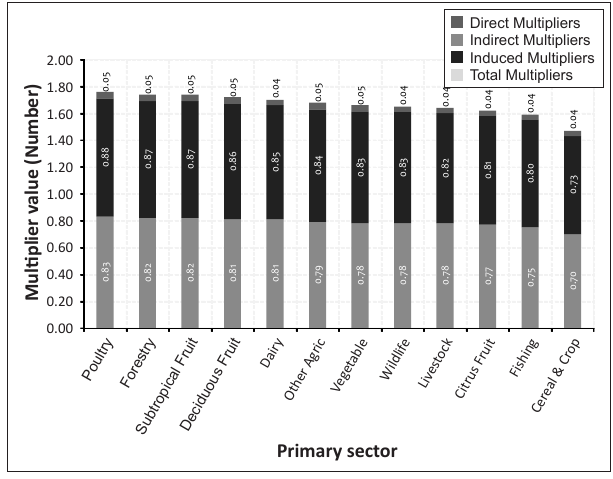
FIGURE 8: Household income